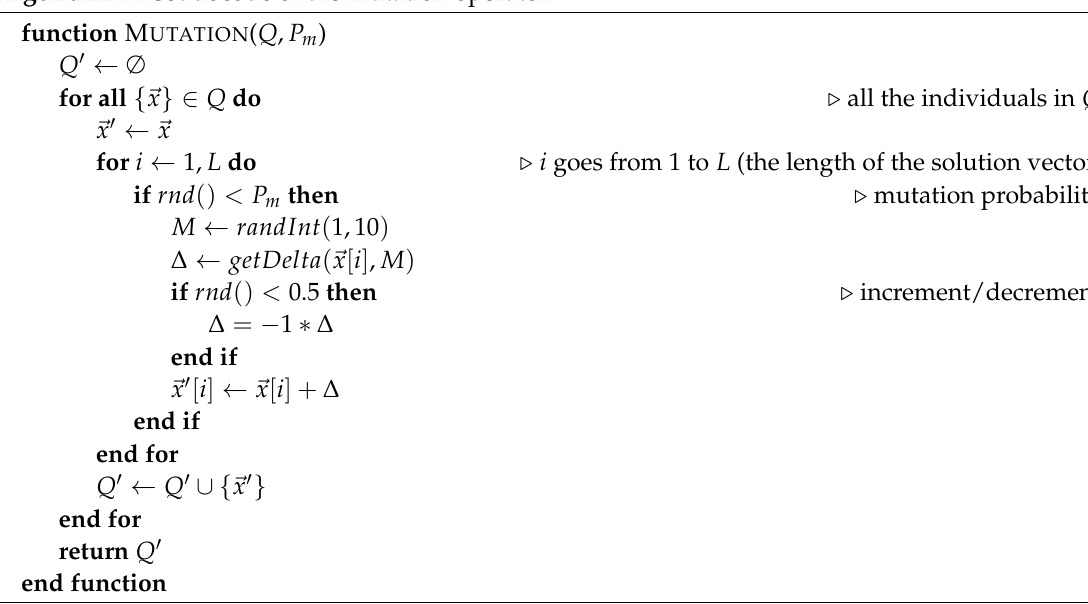
Algorithm 4 Pseudocode of the mutation